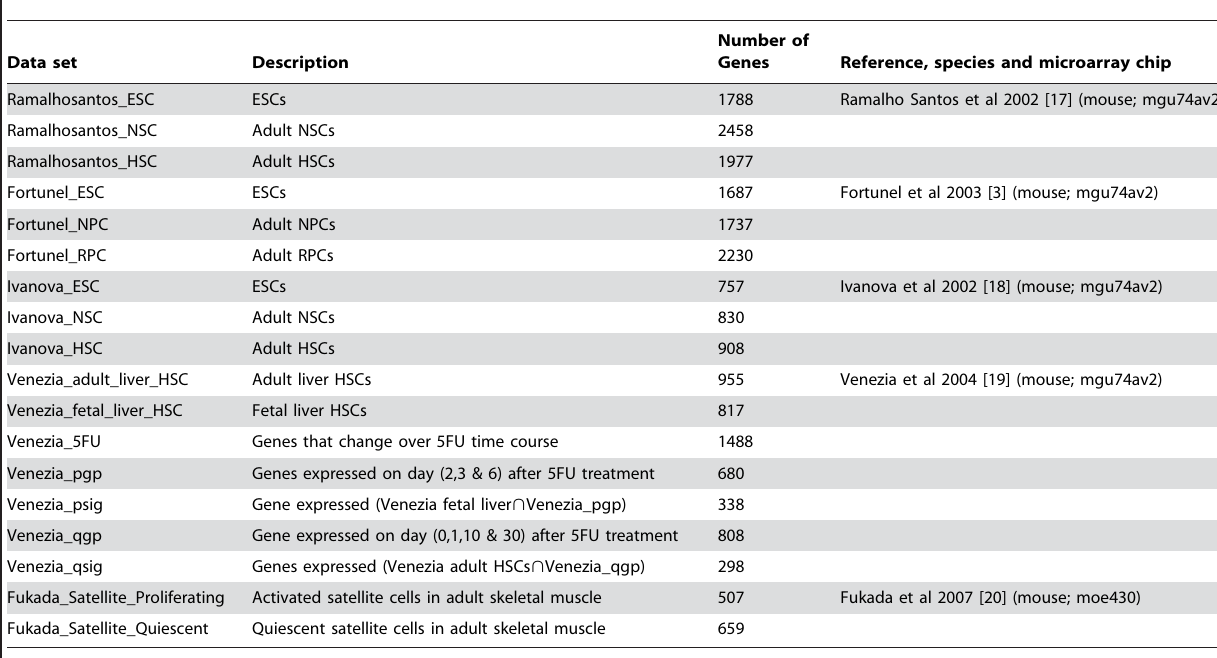
Table 1. The up-regulated gene lists from the 18 different SC microarray experiments included in the meta-analysis.